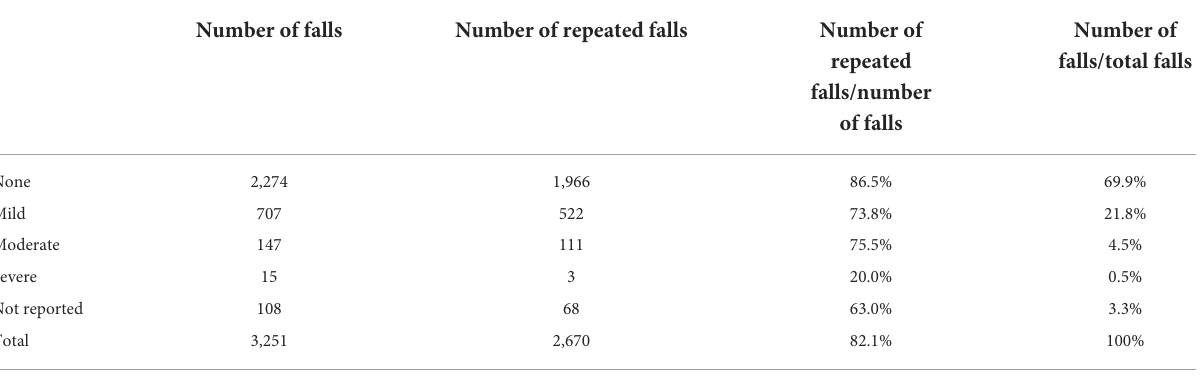
TABLE 5 Data on the physical consequences in the ‘repeated falls’ group (campus Kortenberg). Number of falls Number of repeated falls Number of